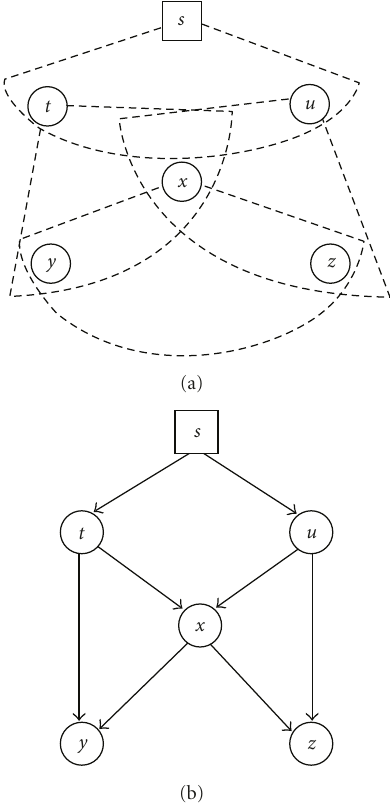
Figure 1: (a) Source s wants to send two messages to sink nodes y and z . t and u are within the coverage of source s , x is within the coverage of t and u , and terminals y and z are within the coverage of x . The region bounded by the dash lines denotes the signal coverage of the broadcast node. (b) The equivalent graph model of